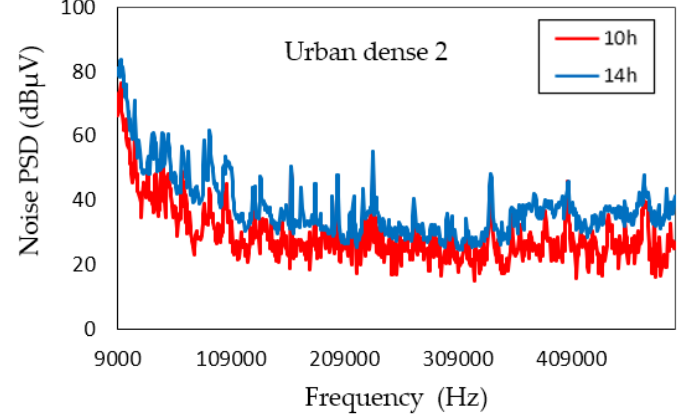
Figure 11. Noise power spectrum in the smart electricity meter. Measurements performed at 10 a.m. and 2 p.m.